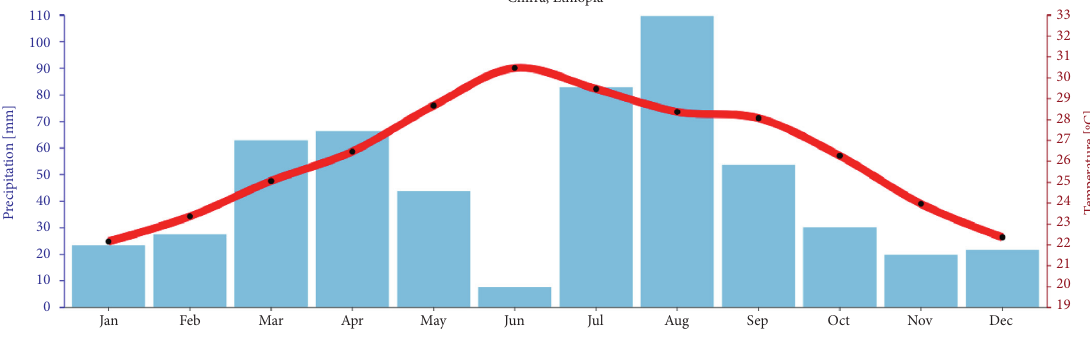
Figure 2: Climate diagram of the study area (blue bars, mean annual rainfall; red trend line, mean annual temperature) (1981–2010) [11]. The x -axis shows the mean annual temperature and rainfall.